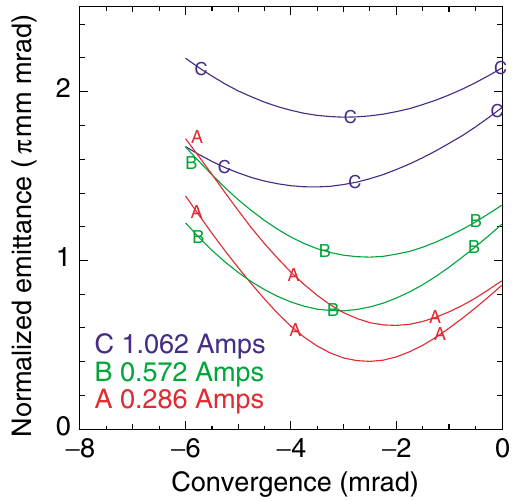
FIG. 7. (Color) The beamlet radii are varied while the clear- ance is held to a constant 0.5 mm.